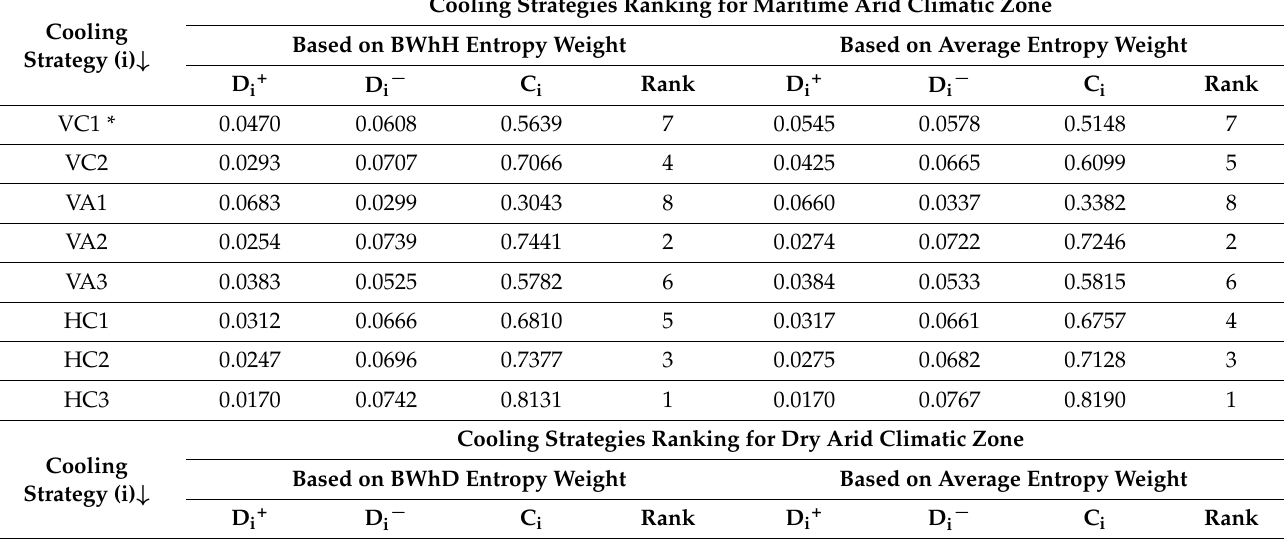
Table 15. Climatic zones, cooling strategies and their ranks using corresponding E j entropy weight values.